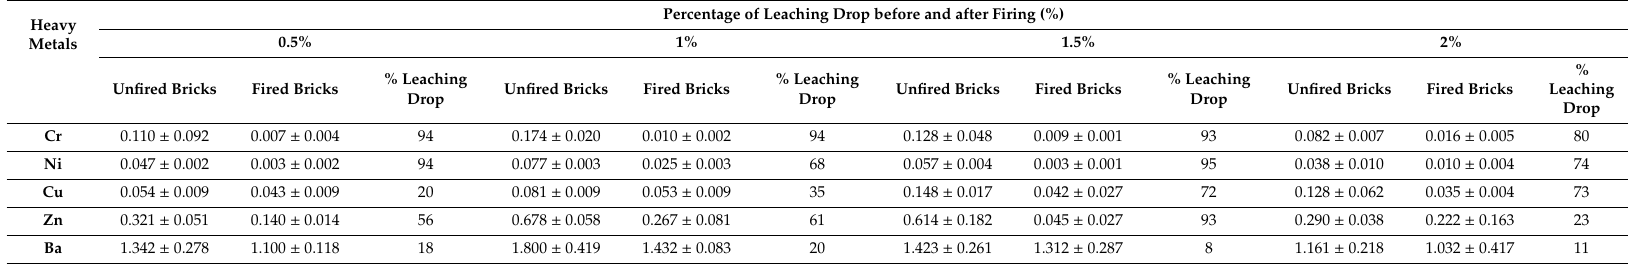
Percentage of Leaching Drop before and after Firing